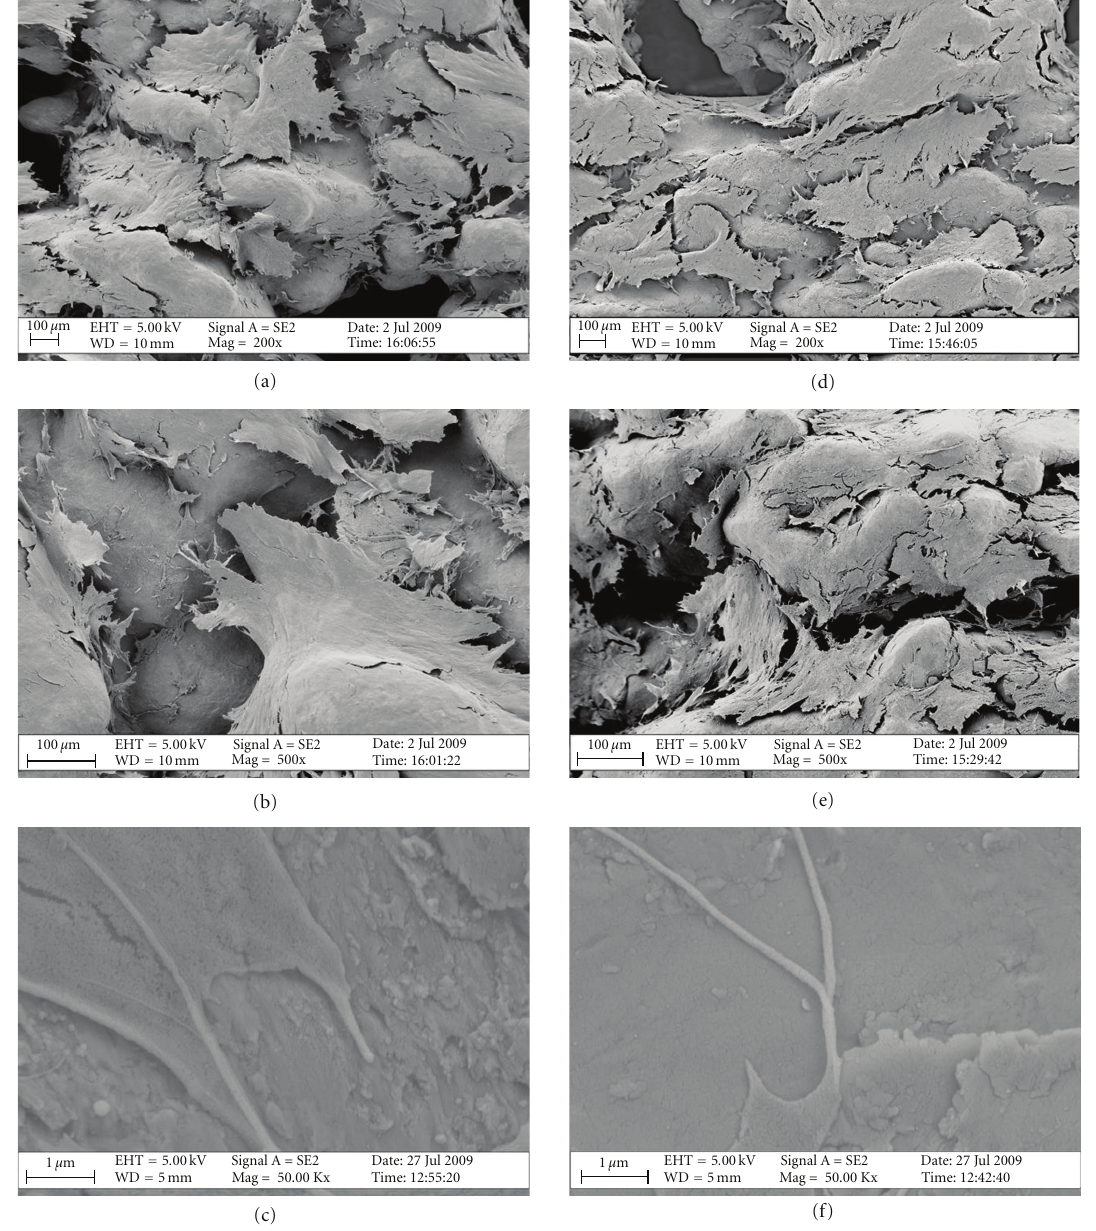
Figure 3: SEM images showing hES-MPs morphology and distribution across the cp-Ti (a–d) and Ti6Al4V (e–h) sca ff olds; scale bar = 200 μ m (a, b, d, and f) and 1 μ m (c and f).